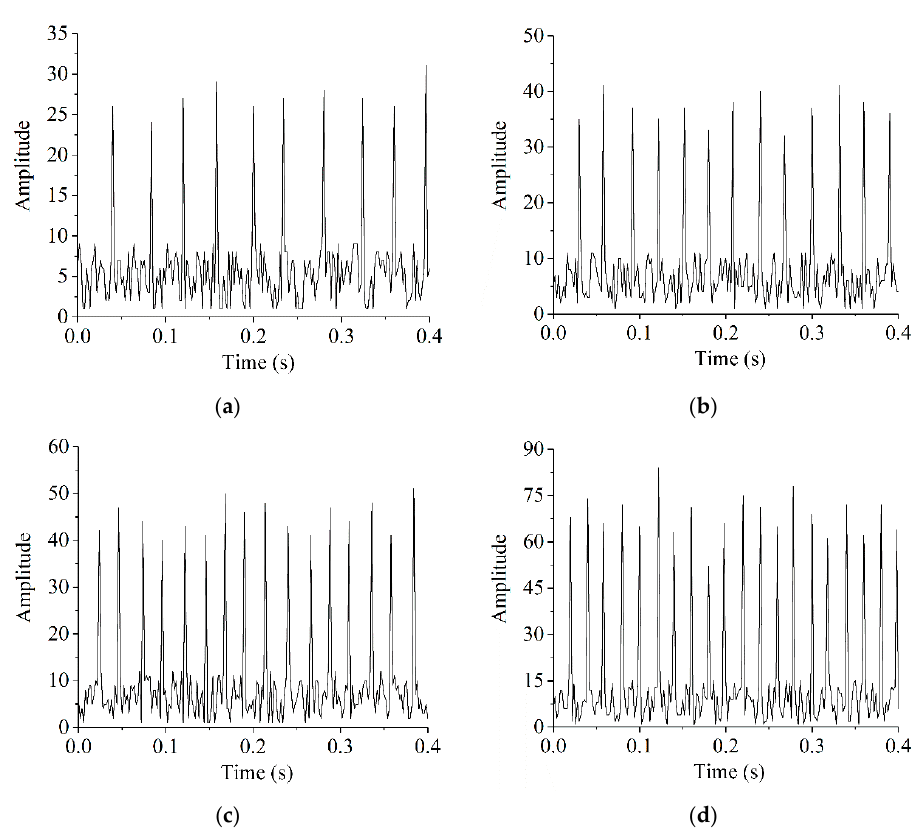
Figure 14. Vibration signal at various rotational speeds: ( a ) n = 1500 rpm; ( b ) n = 2000 rpm; ( c ) n = 2500 rpm; and ( d ) n = 3000 rpm.